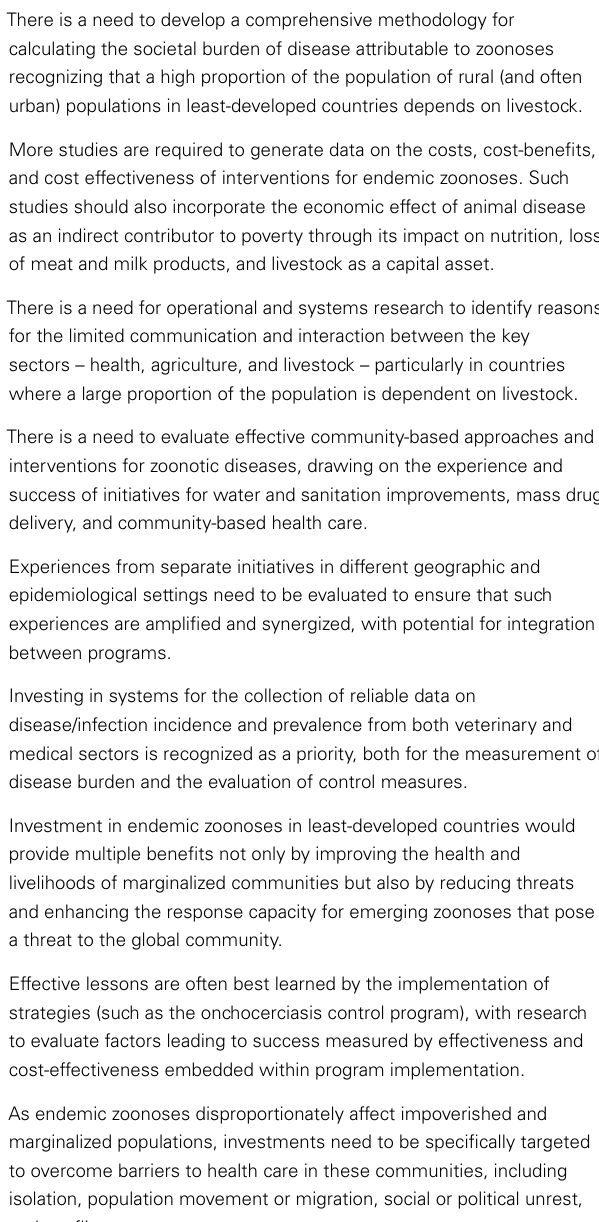
Table 2 | Macro research priorities identified by DRG6 (Disease Reference Group –WHO UNDPWorld Bank Special Programme)